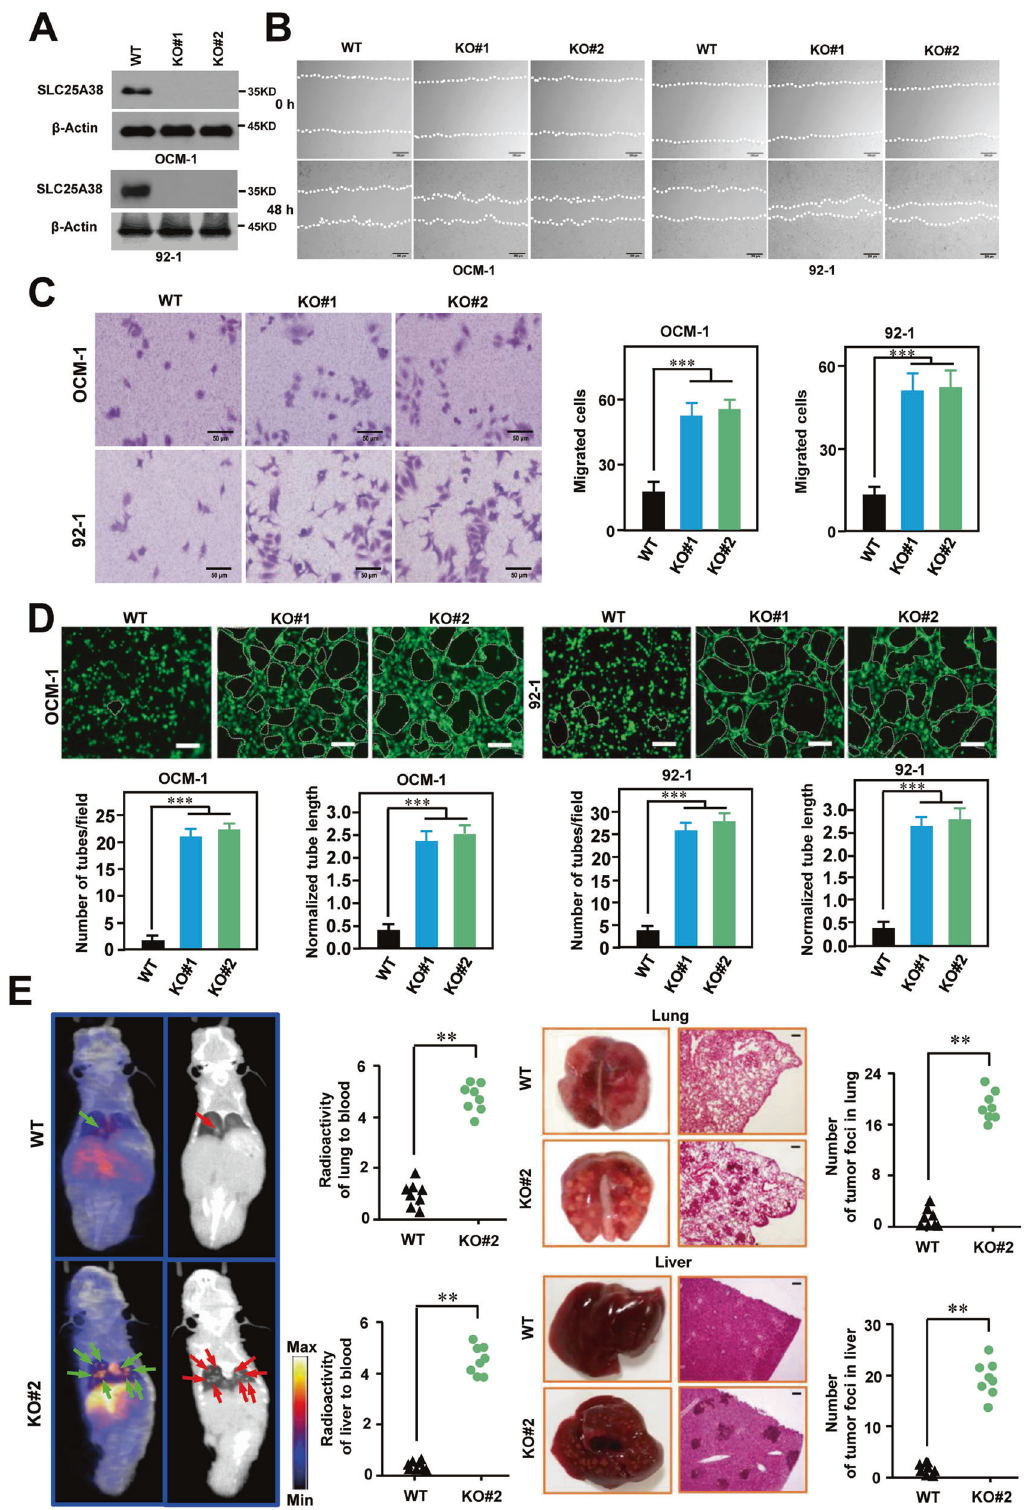
Fig. 4 Silencing SLC25A38 promotes the malignant properties of UM cells in vitro and in vivo. A UM cells with SLC25A38 knock-out were successfully constructed. B , C Wound healing assay ( B ) and transwell invasion assay ( C ) showing that SLC25A38 knock-out could enhance the migration and invasion ability of UM cells. D Vascular ring formation analyses indicate the increasing ability of angiogenesis upon SLC25A38 knock-out. The number of tubes was counted and normalized tube length was calculated, scale bar 100 μ m. E PET imaging and H&E staining showed that mice inoculated with SLC25A38 knock-out UM cells had more lung metastases and live metastases compared to that injected with control UM cells, scale bar 100 μ m.